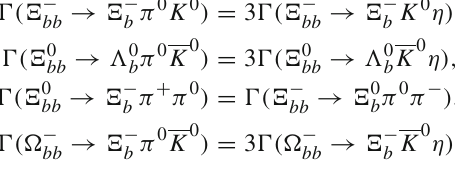
Decays into a sextet heavy baryon have